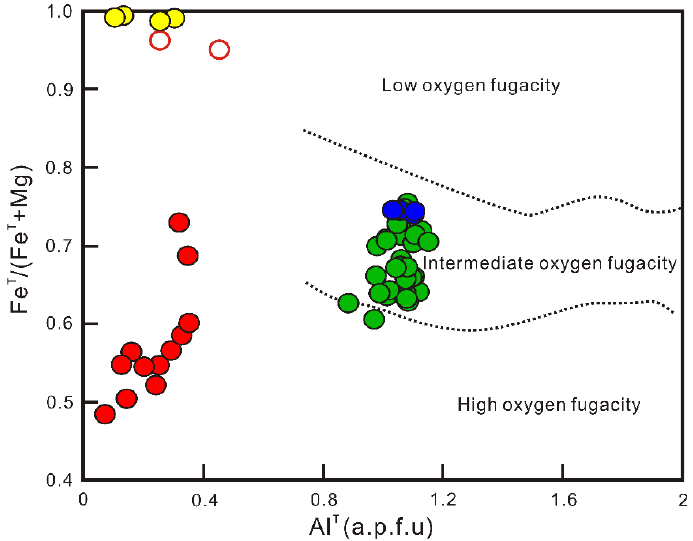
Figure 11. Fe# (Fe T /Fe T + Mg) versus Al T of the amphiboles from the Huangyangshan deposit (after [80]). Symbols are as in Figure 4.